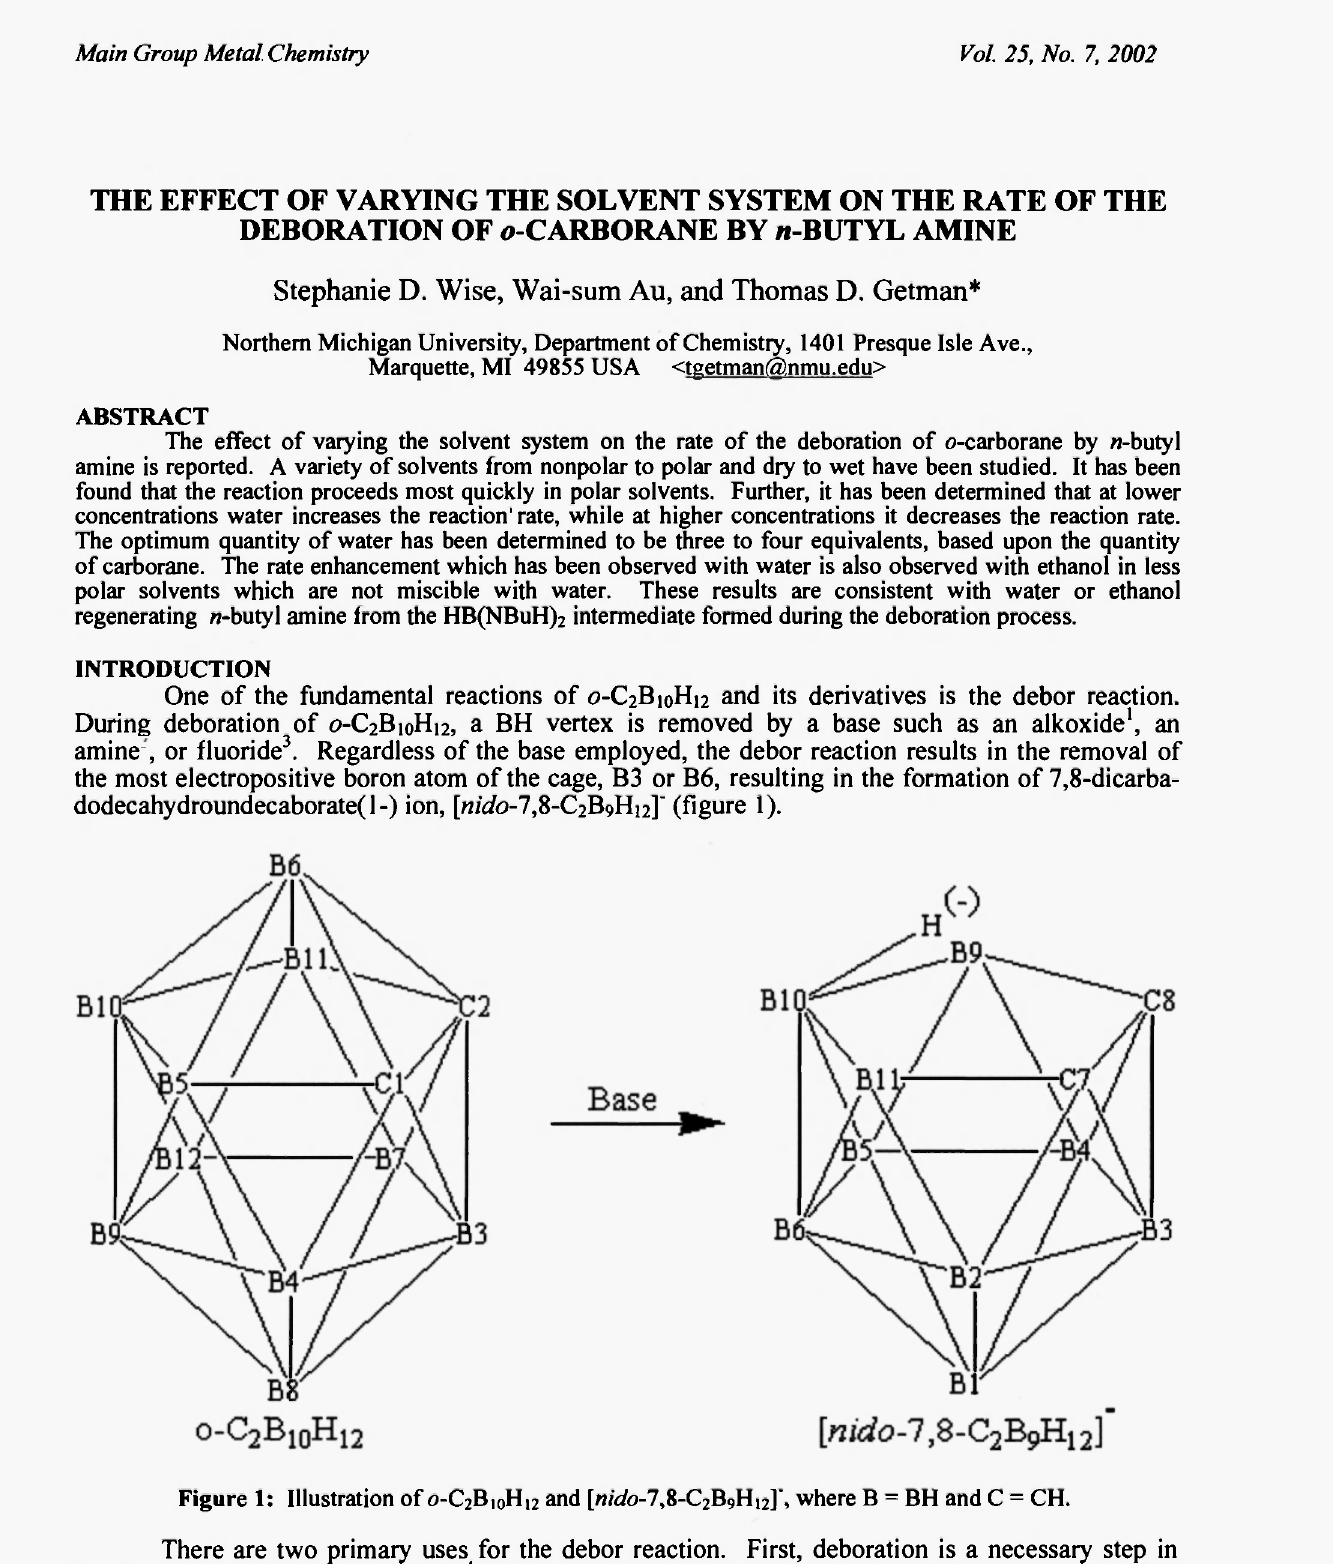
Figure 1: Illustration of O -C 2 B I 0 H 12 and [«/</o-7 ,8 -C 2 B 9 H 12 ]\ where Β = BH and C =